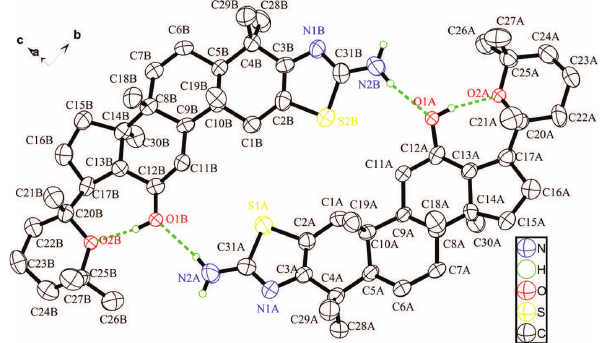
Table 1: Data collection and